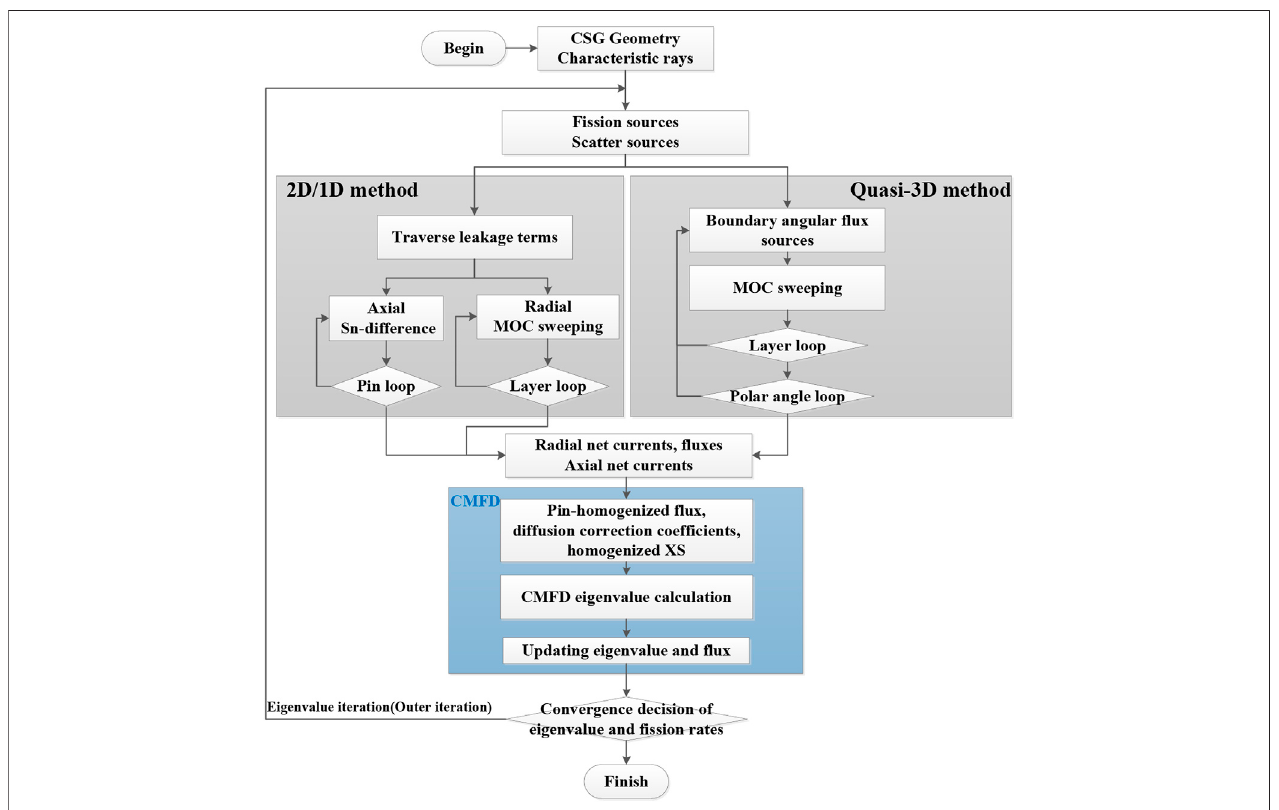
FIGURE 4 | The diagram of the coarse-mesh fi nite difference (CMFD) acceleration in SHARK.